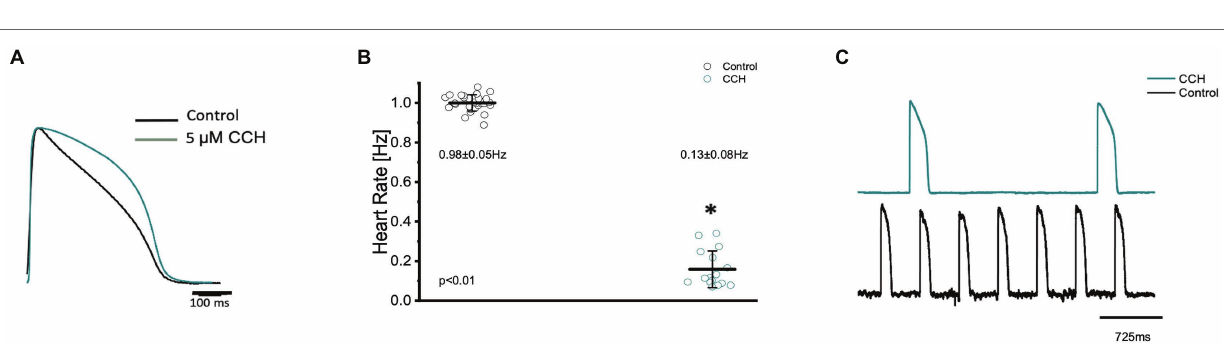
FIGURE 7 | Goldfish ventricular action potential and spontaneous heart rate recordings before (black) and after perfusion with 5 μ m carbamylcholine (green). Administration of carbamylcholine altered the AP morphology (A) and had a negative chronotropic effect, reducing the heart rate from 0.98 ± 0.05 Hz to 0.13 ± 0.08 Hz ( p < 0.01, n = 29 for the control, n = 16 for CCH, N = 4; B ). The negative chronotropic effect following carbamylcholine perfusion is also reflected in spontaneous AP recordings from the left ventricle (C) . * Denotes a significant difference between the two distributions. The data are presented as multiple measurements ( n ; dot cloud) recorded for different measurements ( n ) on different hearts ( N ) with the mean ± SEM (solid